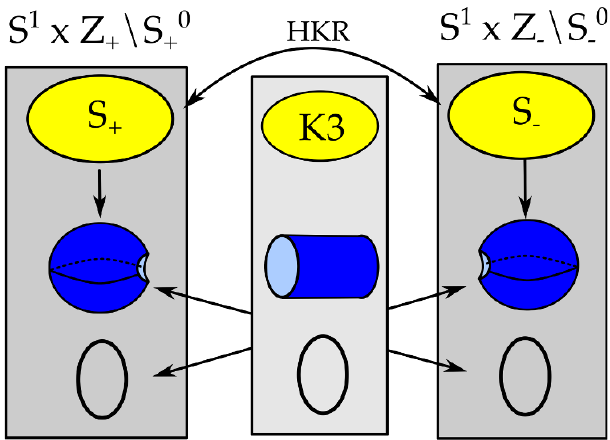
Figure 1 . The twisted connected sum (TCS) construction for G 2 -manifolds: the two acyl Calabi- Yau three-fold building blocks are X (cid:6) = Z (cid:6) n S 0 , where S (cid:6) denotes the K3-(cid:12)bers of each building (cid:6) block. Unlike the Spin(7) case, here the gluing is done with a twist (or a Donaldson matching): a hyper-K(cid:127)ahler rotation (HKR) on the K3-(cid:12)bers, and an exchange of the circles as shown above. The asymptotic region where the gluing is performed is K3 (cid:2) S 1 (cid:2) S 1 (cid:2) I . Topologically the resulting G 2 -manifold is K3-(cid:12)bered over an S 3